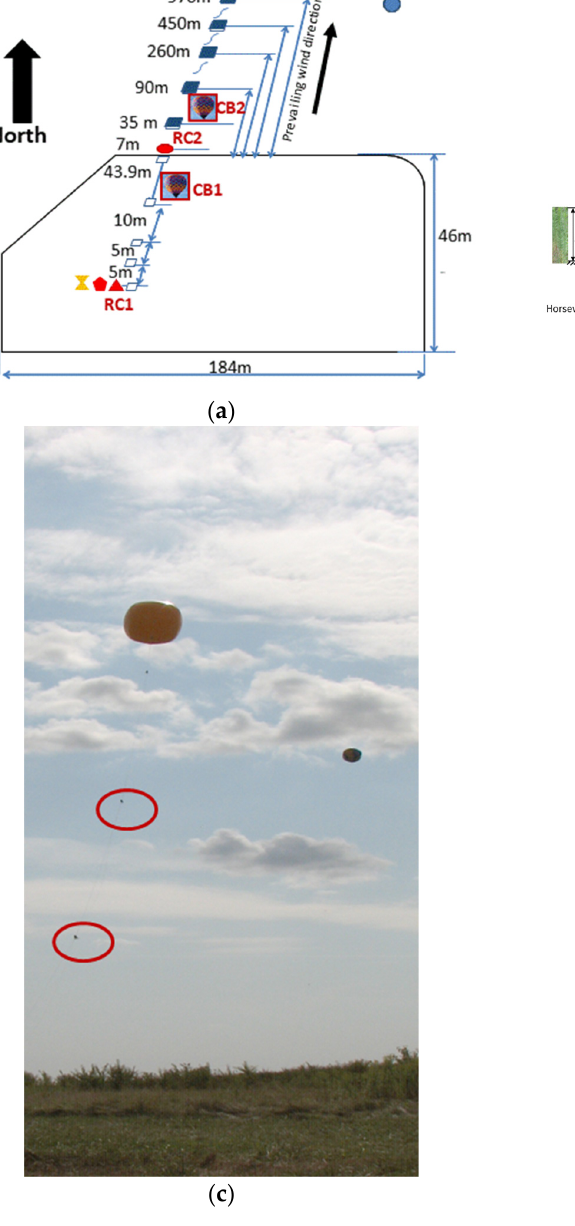
Figure 11. Schematic map and setup of the experiment at the Illinois field: ( a ) Experimental site; ( b ) Sampler heights; ( c ) Floating balloons with Rotorod samplers; ( d ) Rotorod columns. The concentration (grains/m 3 ) was measured by two Rotorod columns (RCi, i = 1 to 2) and balloons (CBi, i = 1 to 2). RC1 was placed at the center of the field with four Rotorod samplers (‘Ci’, i = 1 to 4) positioned at different heights. RC2 was set up at the field edge with three Rotorod samplers (‘CEi’, i = 1 to 3). Two columns of Rotorod samplers (‘CBij’, i = 1 to 2, j = 1 to 5) were mounted below two balloons to measure concentration at greater heights (10 to 100 m). In the picture, the Rotorod samplers were marked with red circles. Deposition (grains/m 2 /s) was the data collected by slides and tiles in and outside of the field at the height of 0.5 m above the ground. One additional sampler, i.e., a continuous record Rotorod (CR) and a sonic anemometer were placed in the